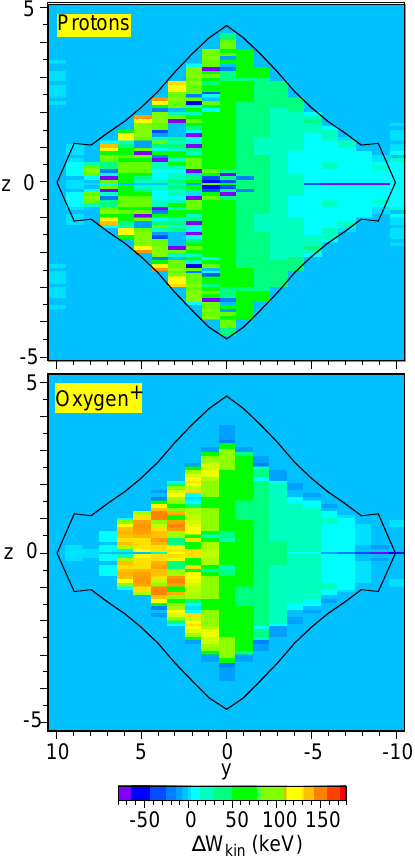
Fig. 10. Characteristics of 180 keV proton and O + fluxes in the tailward direction at x =− 55 and t = 9min, as seen from the tail with dusk to the left. The color coding again represents the en- ergy gain of ions traced backwards in time from the given location, taken as a measure of the flux increase at the given location. The black lines represent the separatrices (boundaries between closed and open field lines) at this location.